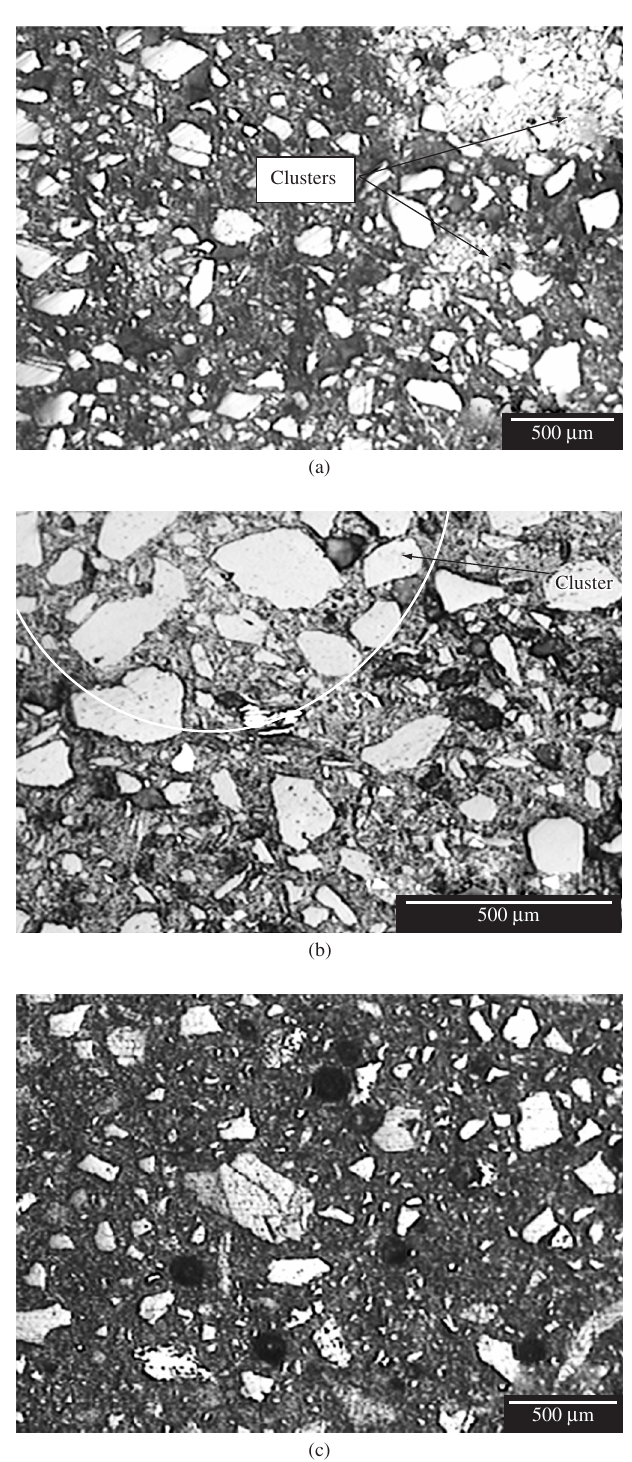
Figure 4. PMC microstructure with 50-50 granite particles ratio and different weight compositions and amplifications: a) 15% epoxy, 50 x ; b) 15% epoxy, 100 x ; and c) 20% epoxy, 50 x